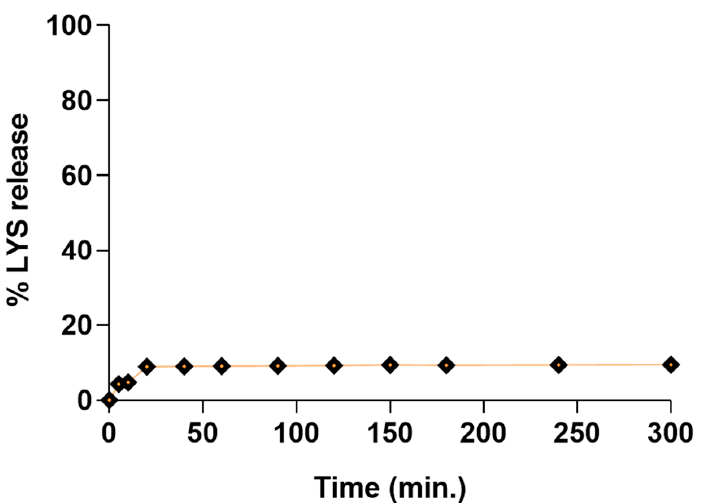
Figure 7. The dissolution profile of LYS from self-emulsifying tablets in PBS (6.8 pH). Solid SEDDSs were composed of liquid SEDDS adsorbed onto Neusilin ® UFL2 at a weight ratio of 1:1. Each value designates the mean ± S.D. ( n = 3).